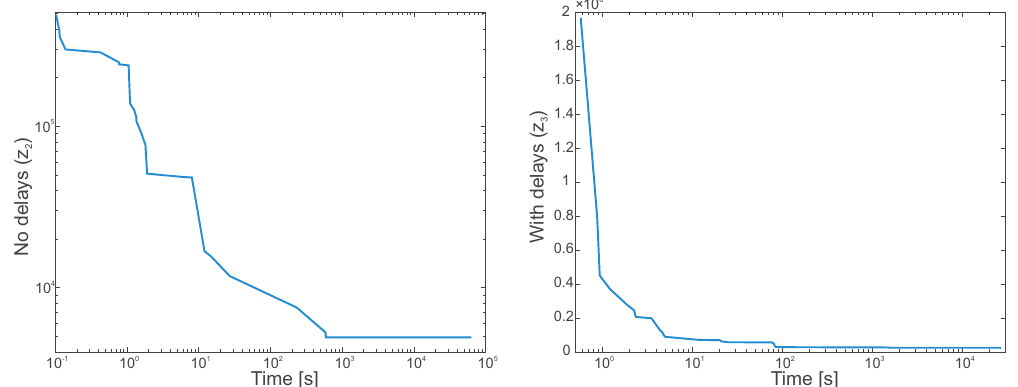
Figure 8. Convergence of criterion functions for the case study with no delays ( left ) and with delays ( right